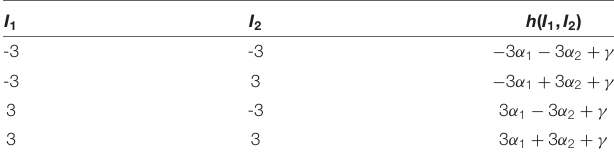
TABLE 2 | Values of h ( I 1 , I 2 ) in Equation 16.